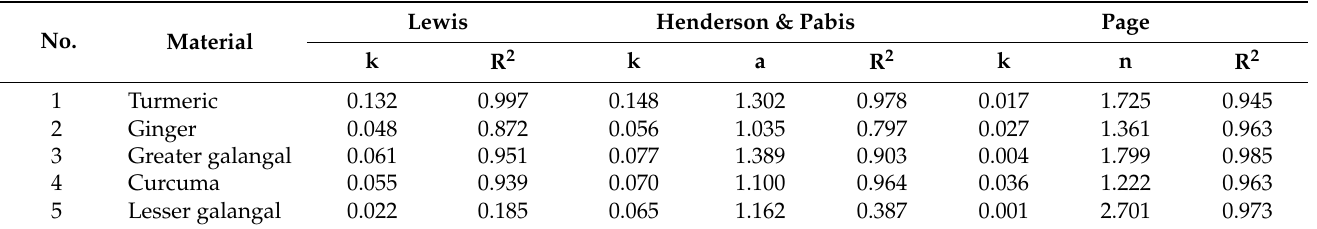
Table 4. Empirical constants of the drying models of medicinal plant drying in the Polydryer with heater operation calculated from Lewis, Henderson and Pabis, and Page models.